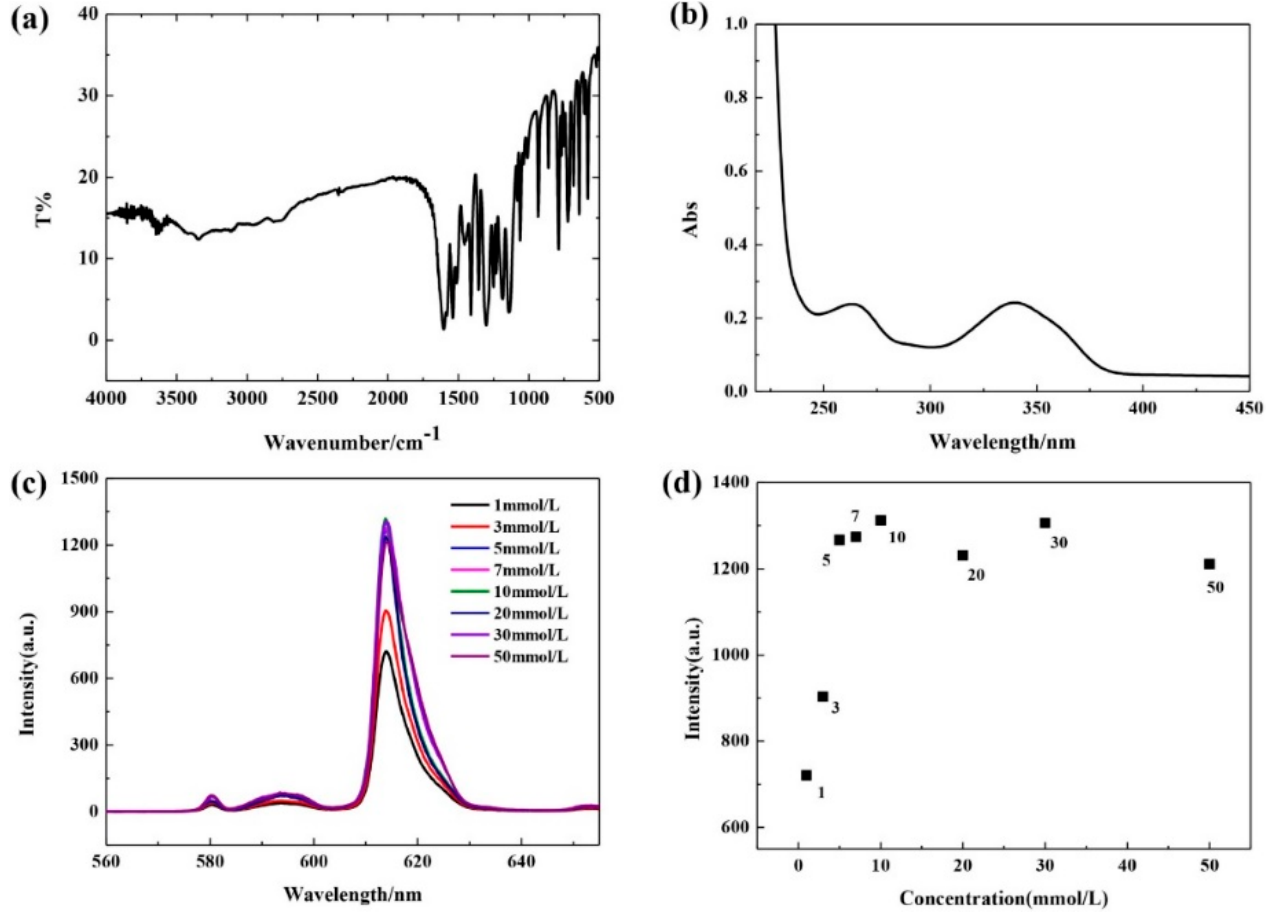
Figure 3. ( a ) Fourier transform infrared (FTIR) spectra, ( b ) UV absorption spectrum of Eu (TTA) 3 (H 2 O) 2 complexes, ( c ) fluorescence emission spectrum of Eu (TTA) 3 (H 2 O) 2 complex films with different concentrations under 339 excitation and ( d ) dot plot of luminescence intensity at 614 nm. The UV absorption spectra of Eu (TTA) 3 (H 2 O) 2 complexes in butanol solution were